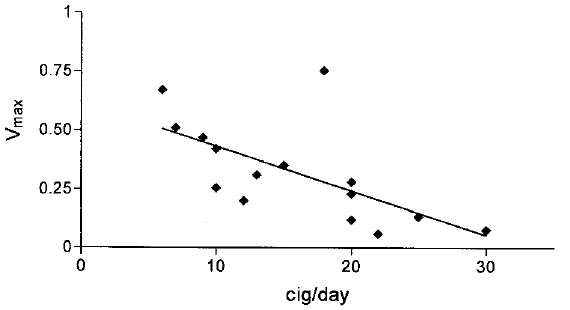
FIG. 2. Correlation of reactive oxygen species production and smoking. R = –0.67, p < 0.01 (Spearman rank test). V max : maximum velocity of reactive oxygen species pro- duction,nmol/min/10 6 cells; Cig/day: number of cigarettes smoked per